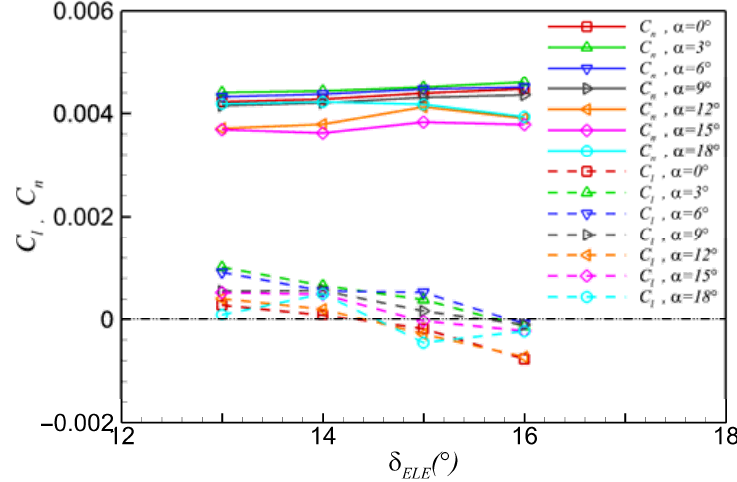
Figure 18. Variation of yawing and rolling moments with δ deflection of elevon (at δ SSD3 = 45°) at different α .